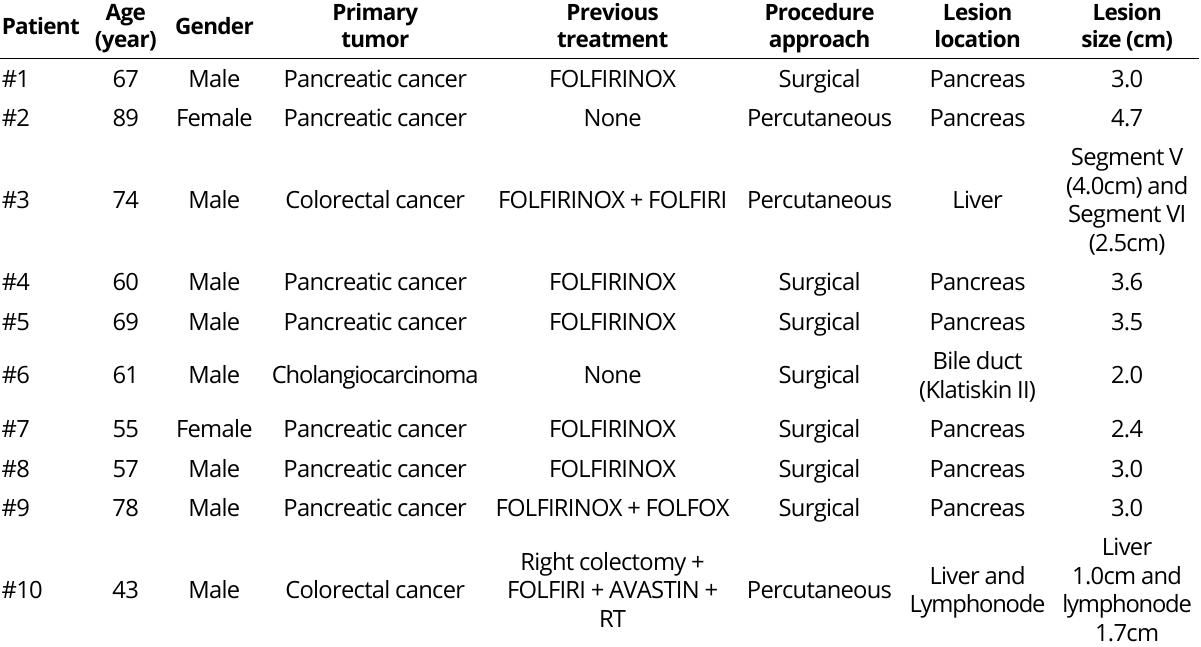
Table 1. Patient